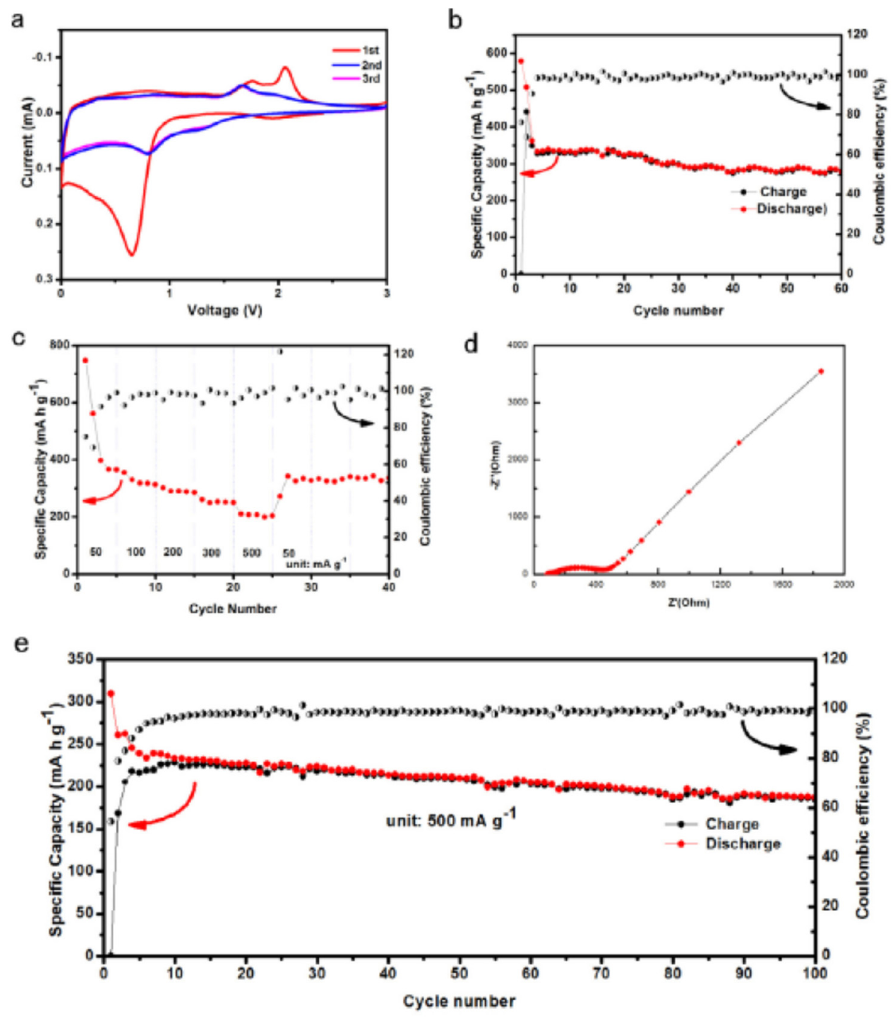
Figure 15. ( a ) CV at a scan rate of 0.05 mV s − 1 . ( b ) Cyclic performances of the NiS 2 anode at 100 mA g − 1 . ( c ) Rate performances of the NiS 2 anodes. ( d ) Nyquist plots of the NiS 2 electrodes. ( e ) Cycling performance of the electrode at a high current density of 500 mA g − 1 [76]. Reproduced with permission.